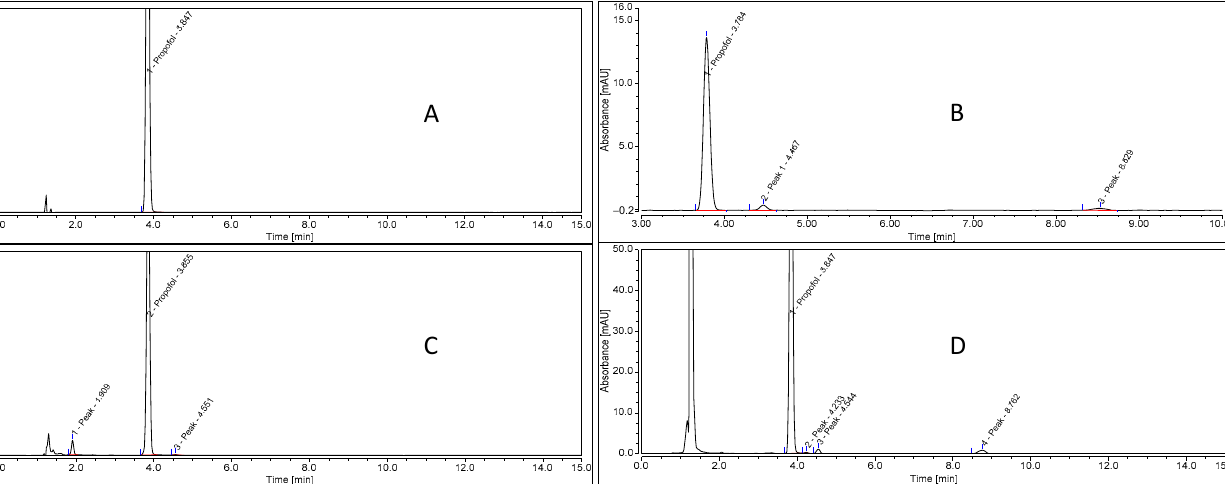
Table 8. Effect of heat sterilization and pH adjustment on chemical stability of propofol *. Propofol Peak (%) Degradation Peak at 8.5 min (%) Before heat After heat Before heat steriliza- sterilization sterilization